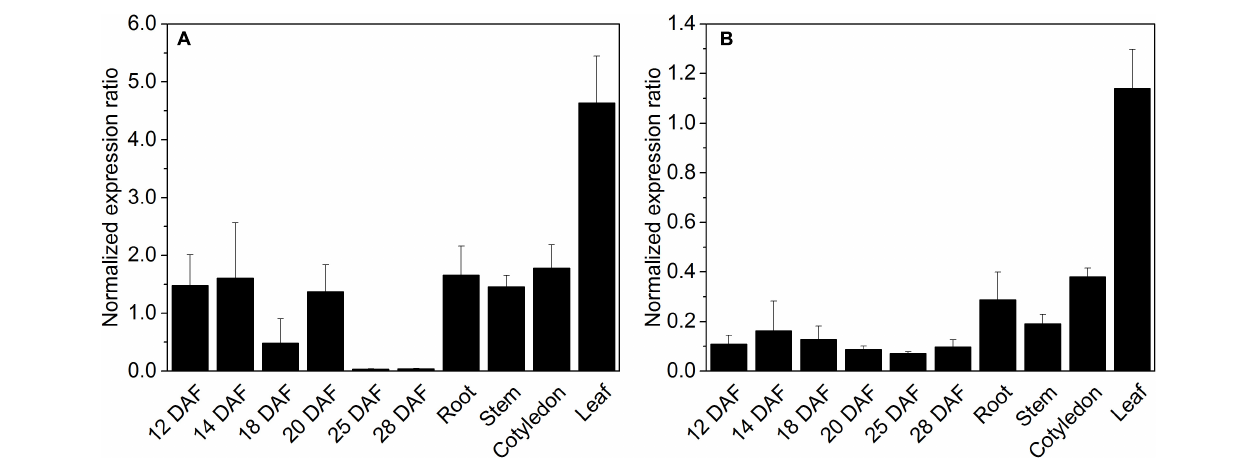
FIGURE 7 | Expression of octanoyltransferase HaLIP1m (A) and lipoyl synthase HaLIP2m (B) in Helianthus annuus seeds at different developmental stages and in distinct tissues. Gene expression was normalized to the expression of HaACT1 : DAF, days after flowering. The data represent the average values ± SD of three independent samples.